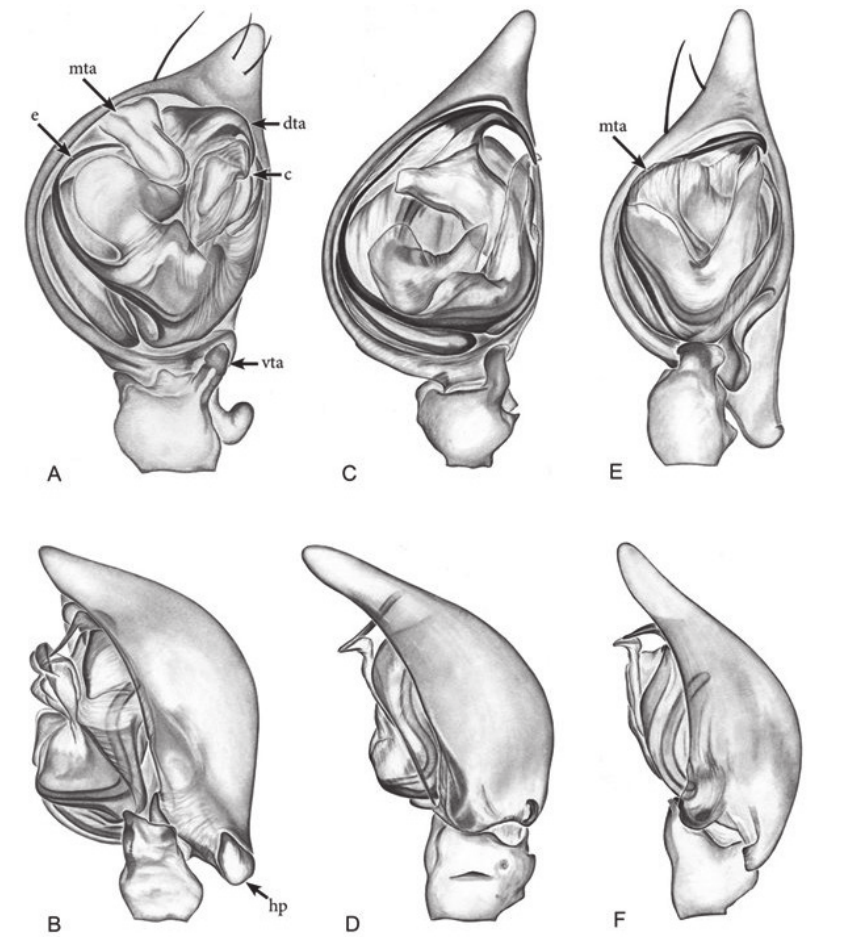
Figure 19. Oxyopes amoenus L. Koch, 1878 ( ZMH- A0000029); A , male palp, ventral view; B , palp, retrolateral view. Oxyopes gracilipes (White, 1849) ( ZMH- A0000007); C , palp, ventral view; D, palp, retrolateral view. Oxyopes punctatus L. Koch, 1878 ( ZMH- A0000017); E , palp, ventral view; F , palp, retrolateral view. Description. Female (Lectotype,